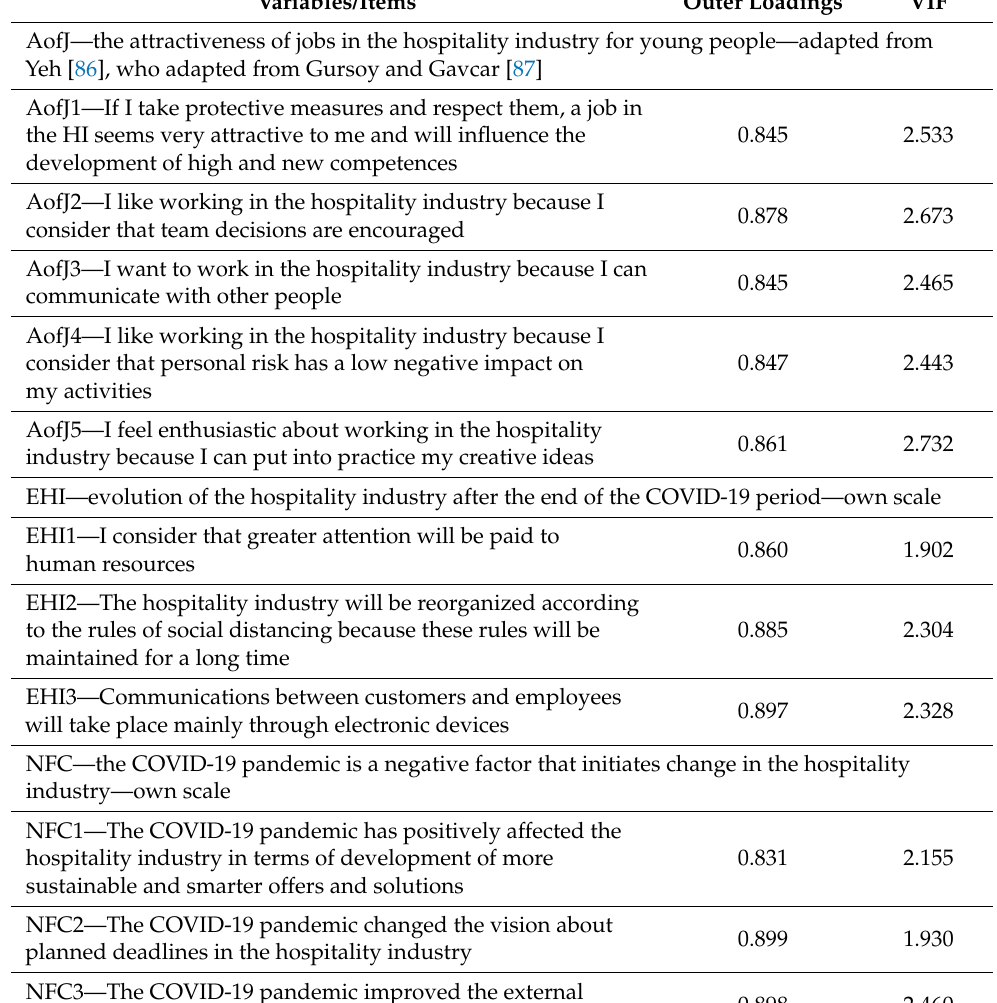
Table 1. Outer Loading and Variance Inflation Factors